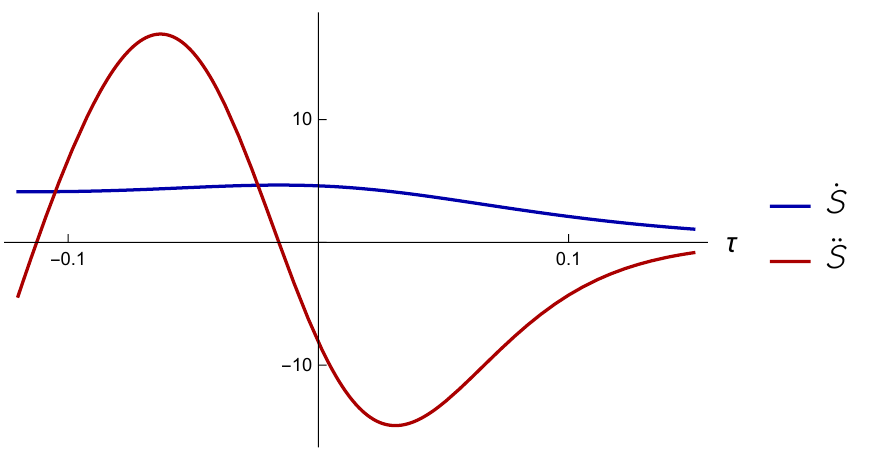
˙ ¨ S ( T ) , S ( T ) as a function of τ , for c B = − 1 , r = − 1 . 4